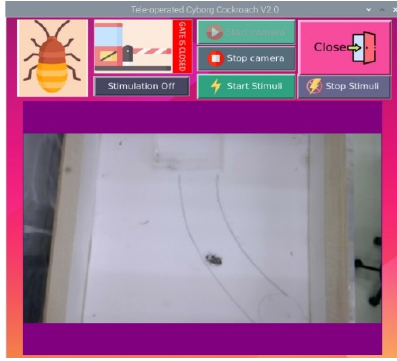
Figure 5. Remote user interface accessed in Bangladesh.2.3.2. Local user interface.